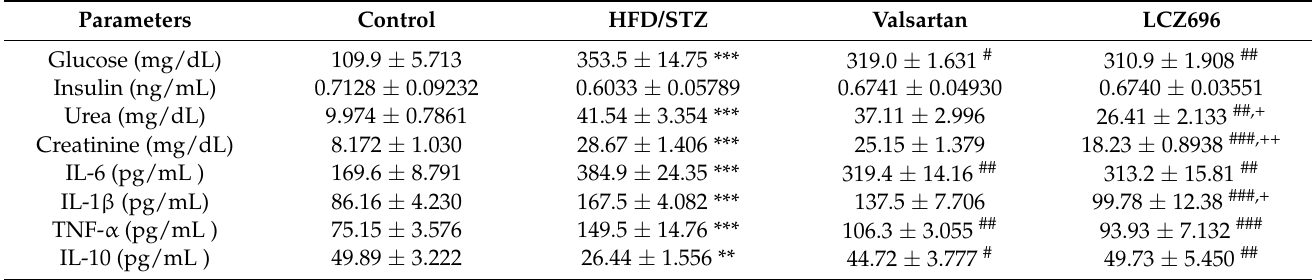
Table 1. The effects of LCZ696 and valsartan treatment on serum glucose, insulin, creatinine, urea, and cytokine levels in HFD/STZ-induced diabetic